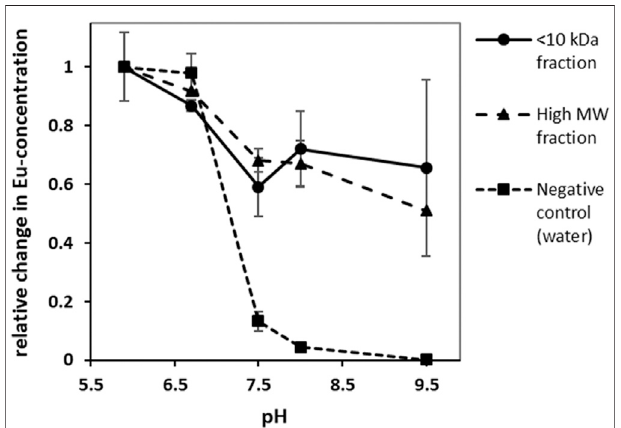
FIGURE 7 | Change in europium-concentration at different pH-values; without the addition of REE-interacting chelators europium precipitated at highpHvaluesleadingtoadecreaseinEu-concentration.InpresenceofREE- interacting chelators however a signi fi cant proportion of europium remained in solution. (error bars indicate ± σ , n = 3).